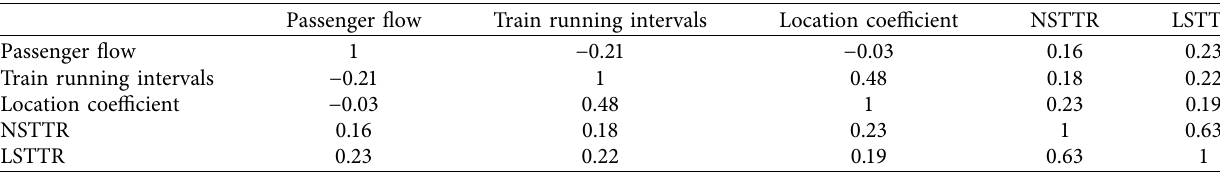
Table 5: Correlation coefficient matrix.